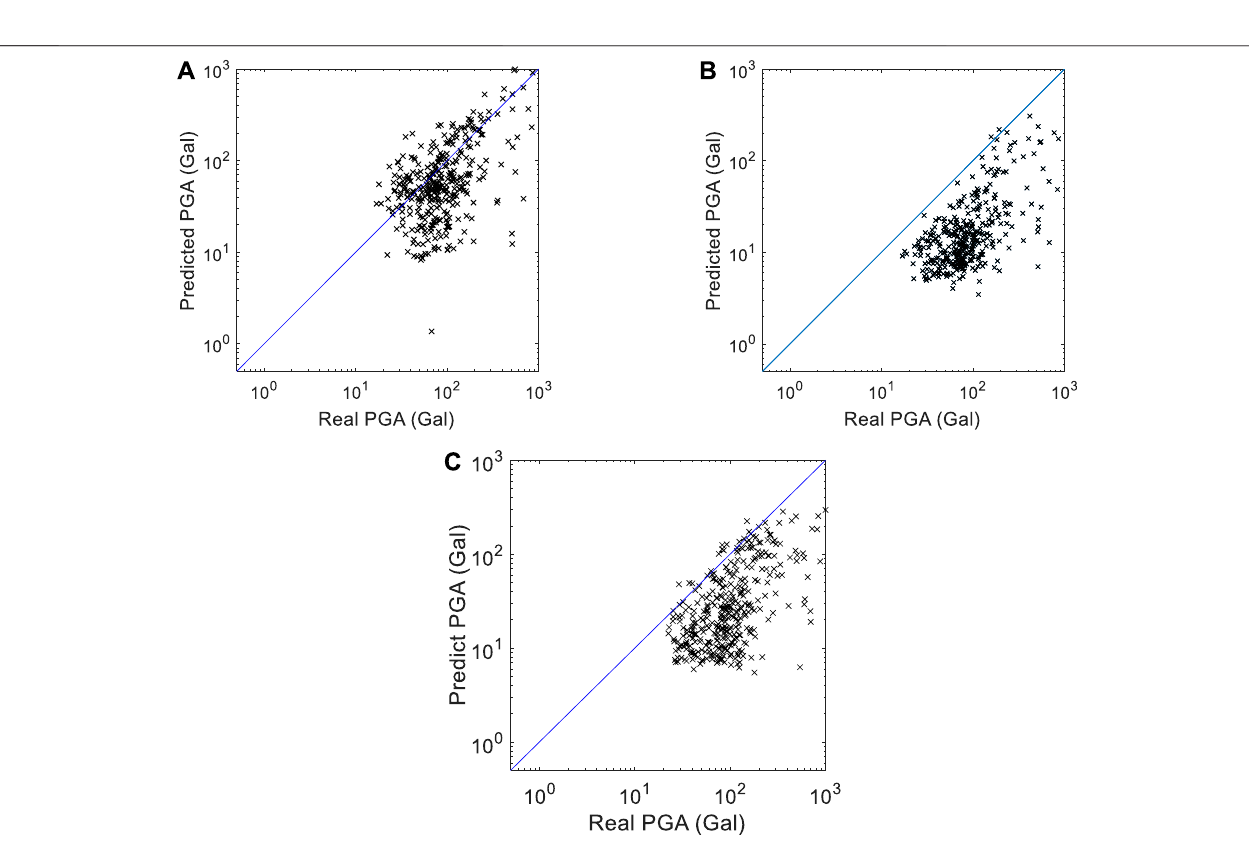
Frontiers in Earth Science |